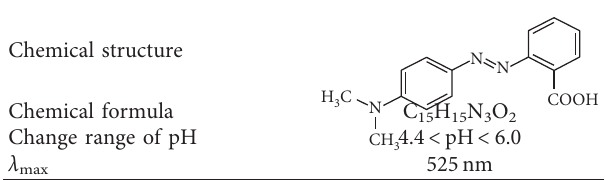
Table 1: Characteristics of methyl red (MR).